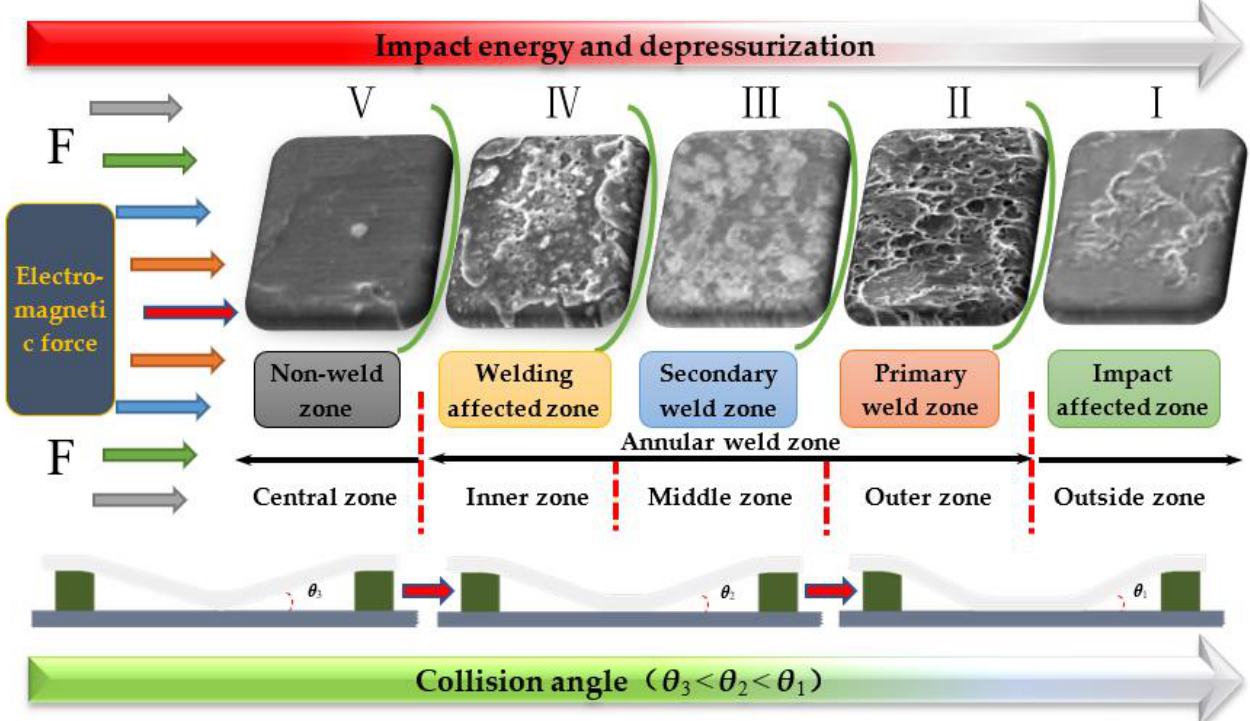
Figure 7. The evolution of hierarchical morphology of collision surface with changing impact energy, collision angle, and depressurization. Table 3 . Schematic diagrams showing the effect of impact-related factors on the interfacial characteristics.